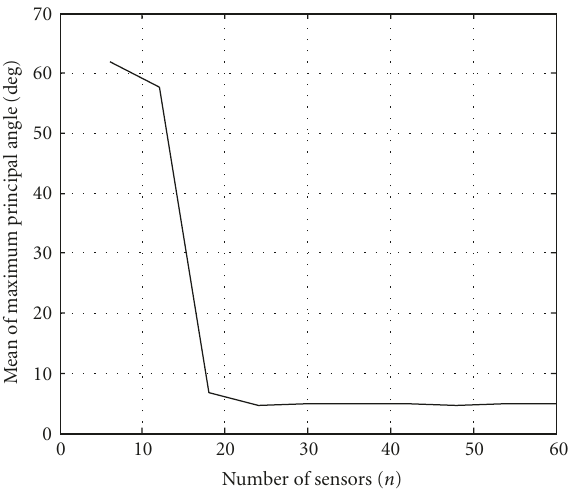
Figure 9: Mean of maximum principal angle versus number of sen- sors for five stationary sources located at [ − 10 ◦ , − 5 ◦ , 0 ◦ , 5 ◦ , 10 ◦ ] .